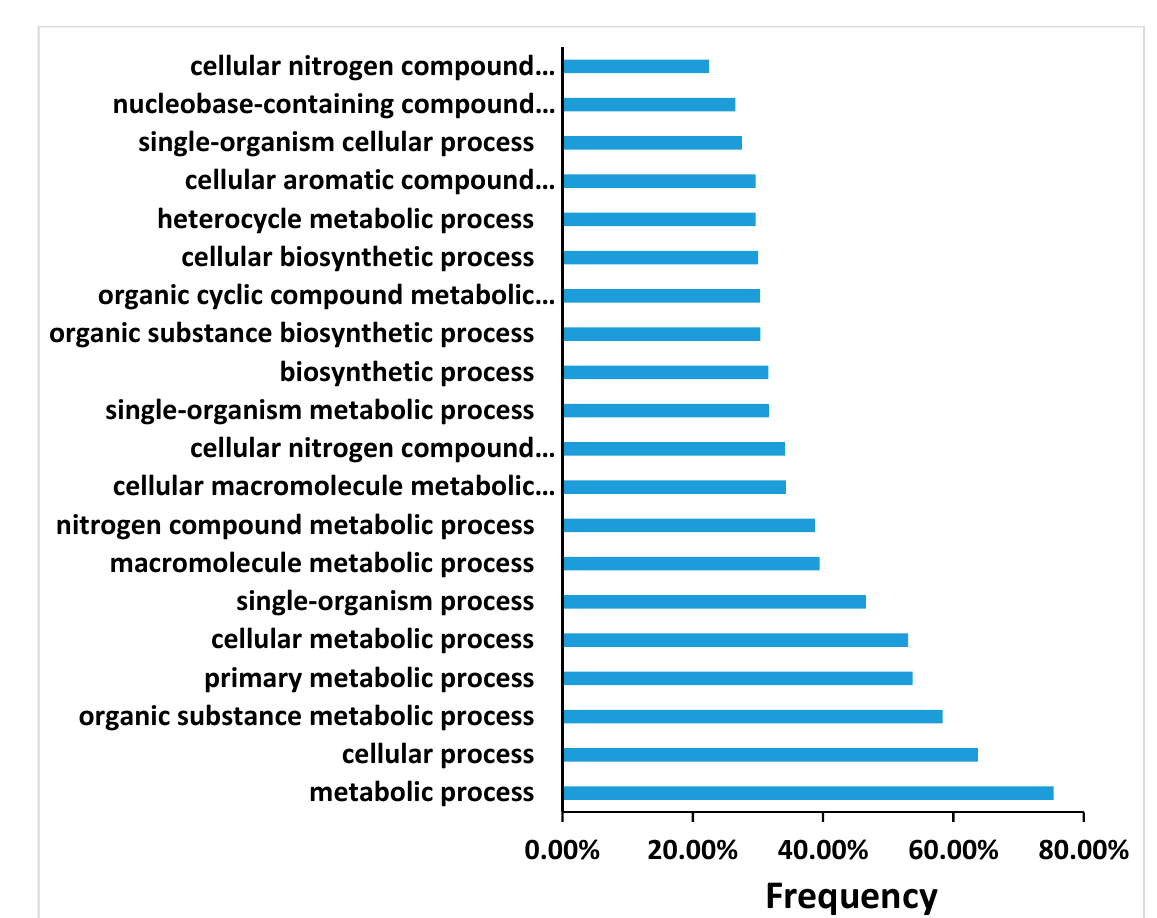
Figure 7. A sample of transcript analyses of top 20 biological processes that upregulate at day 4 of the induction of shoot regeneration. Only some of the processes were fitted on the Y-axis.